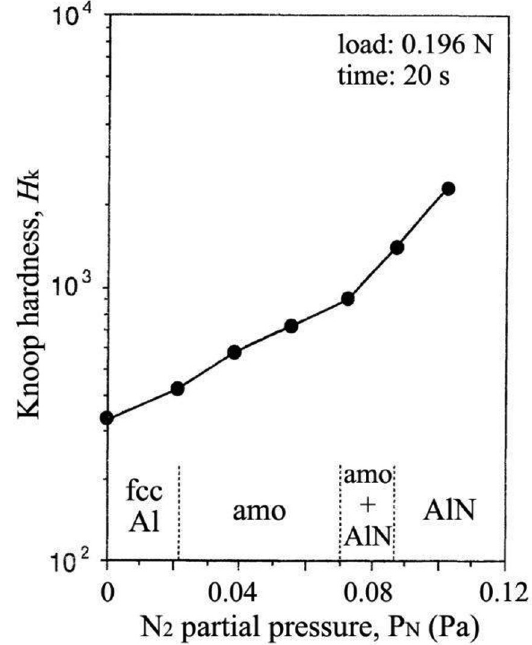
Figure 13. Knoop hardness number ( H the fcc-Al(Ti), amorphous Al(Ti, N), amorphous plus hexagonal Al(Ti)N and hexagonal films 57